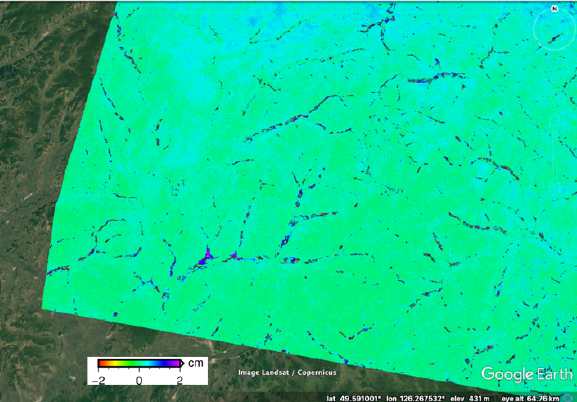
Figure 4. Spatial distribution characteristics of permafrost deformation